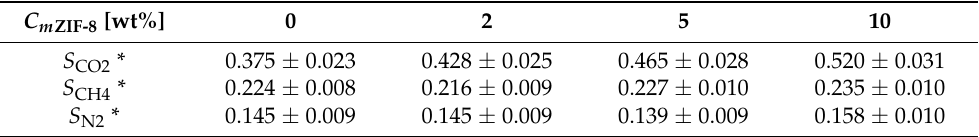
Table A4. Solubility coefficient S i for membranes of different ZIF-8 concentrations. * The values in table should be multiplied.